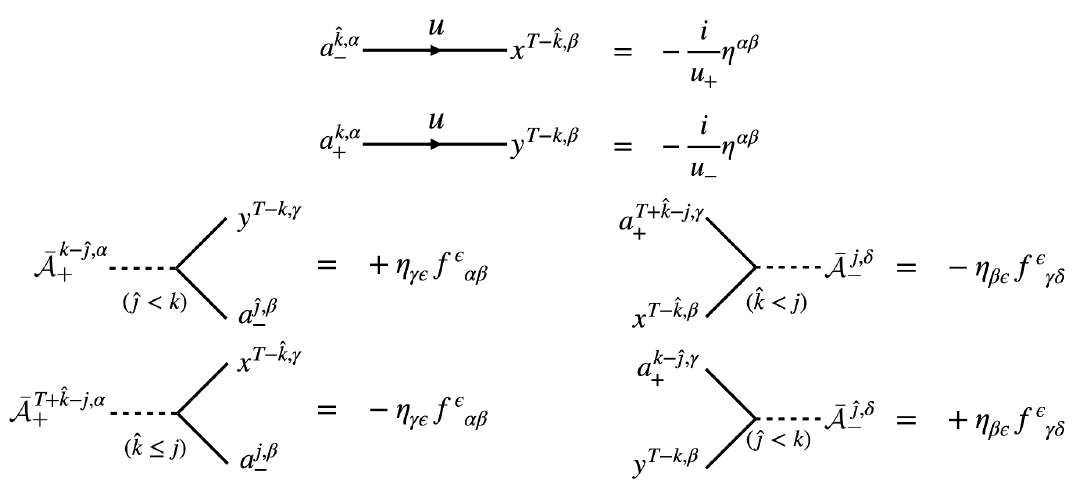
Figure 3 . The Feynman rules following from the path integral (3.7). Recall the ranges of the integer-valued indices 0 < j ≤ k < T and 0 ≤ ˆ , ˆ k < T . We denote ¯ A k